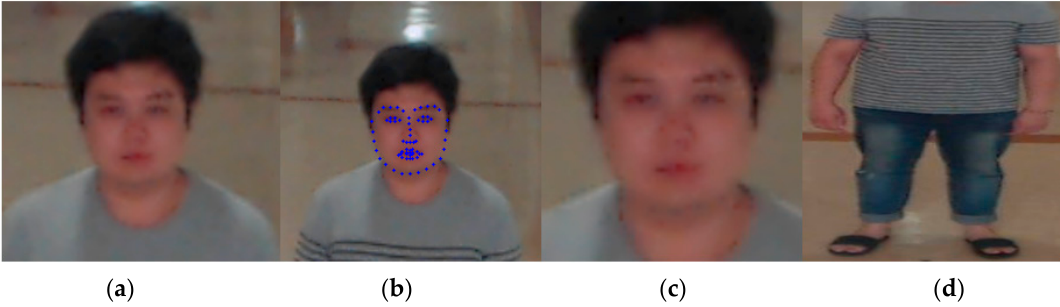
Figure 2. Detection of face and body region. ( a ) Face region detected by AdaBoost algorithm from input image, ( b ) facial landmarks detected in face region by dlib facial feature tracker, ( c ) redefined face region based on eye landmarks, ( d ) defined body region.